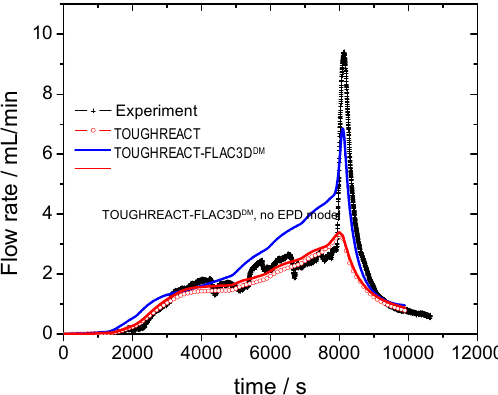
Figure 12. Comparison between predicted and experimental gas flow rate.